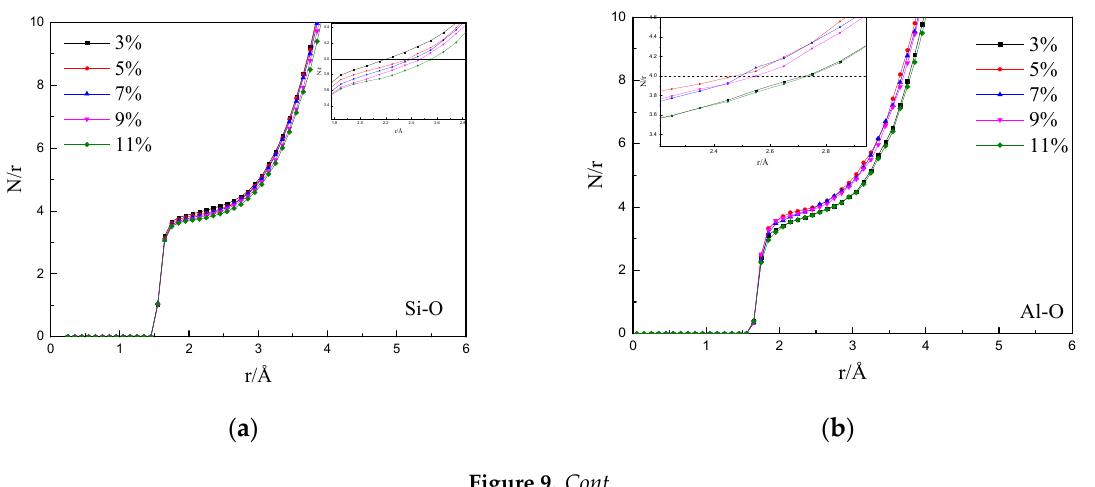
( c ) Figure 9. Coordination number function of ( a ) Si–O ( b ) Al–O and ( c ) Ca–O at different CaF 2 contents.